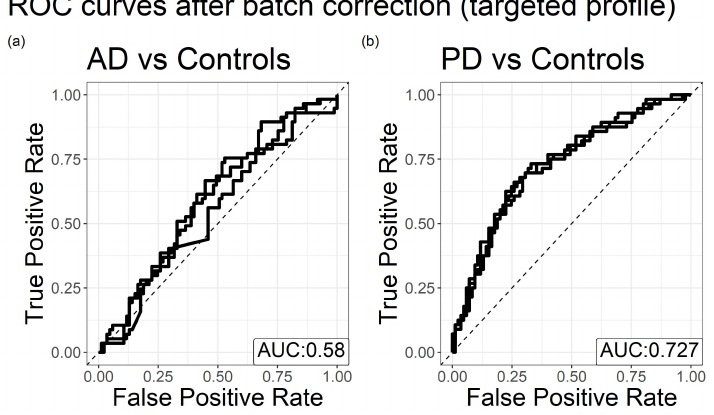
Figure A7. ROC curves displaying leave one out predictive accuracy of models fit on the targeted profile after the batch orthogonalization procedure. We find that these models are largely unable to distinguish AD from controls after this procedure ( a ), and are still able to distinguish PD from controls (but with less predictive accuracy compared to the results in the main analysis) ( b ).